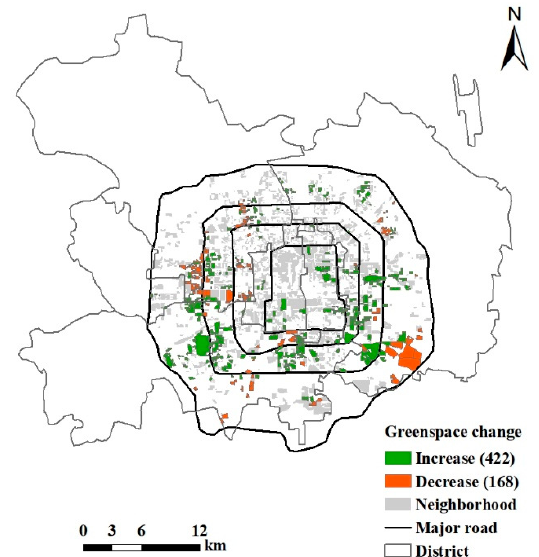
Figure 10. Greenspace change in neighborhoods with less than average accessible greenspace (24%) and high